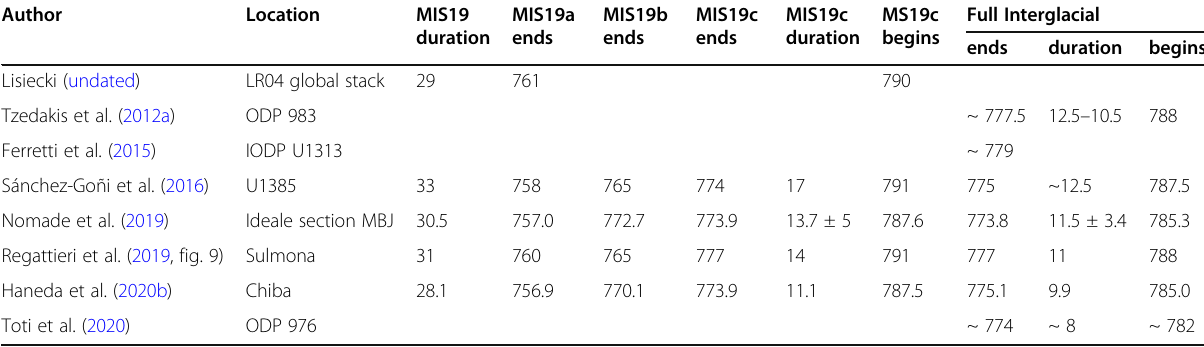
Table 2 Extent and duration of MIS 19 and its substages and of full interglacial conditions. Ages and durations (in ka/kyr) are based on the age models published for each